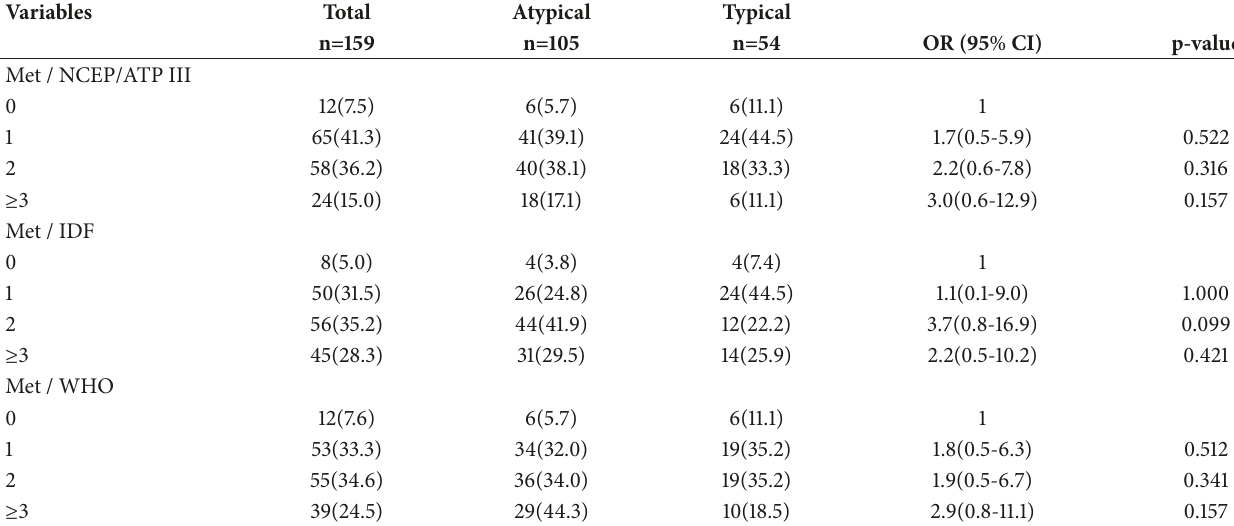
Table 3: MetS among studied subjects treated with atypical and typical antipsychotics.